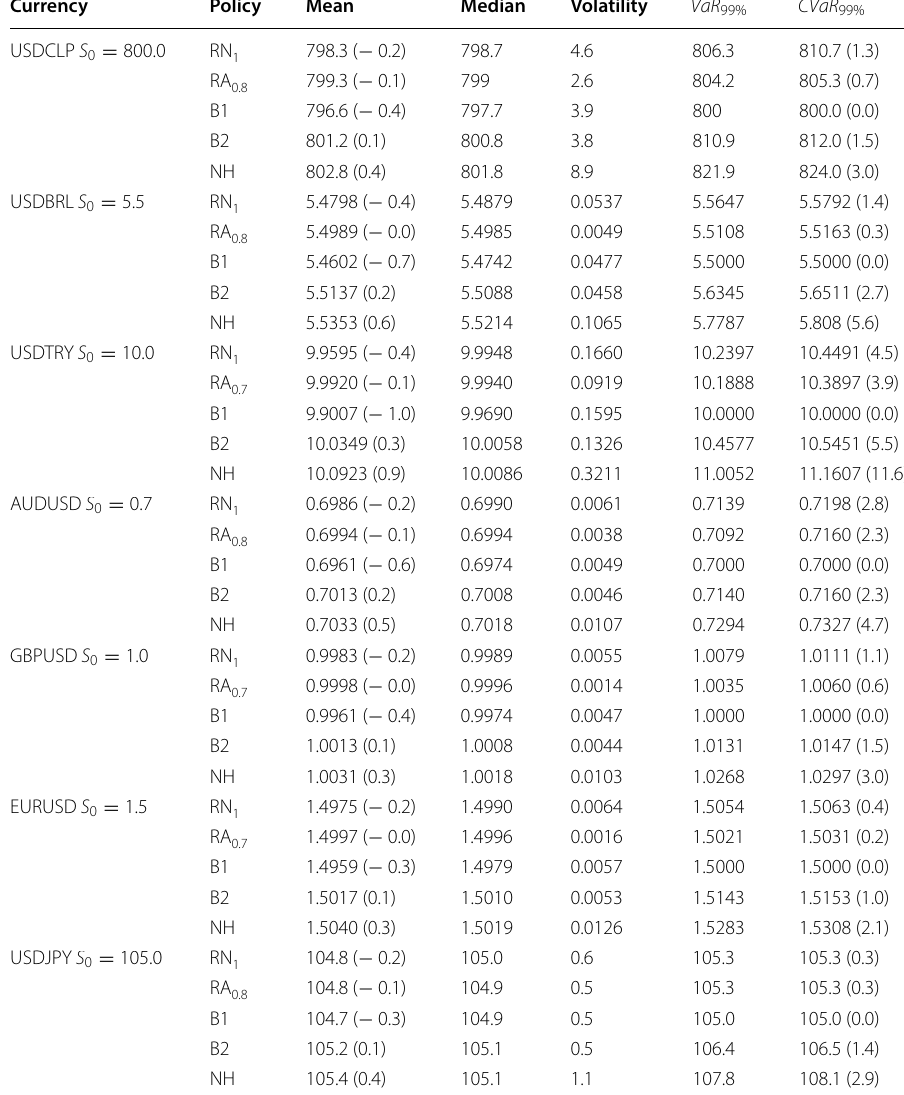
The statistics are obtained from the total cost in domestic currency divided by total demand D ( 3.75%,1.25% ) . The numbers in parenthesis are the rate of increase (reduction) (%) relative to S results when (π u , π d ) =